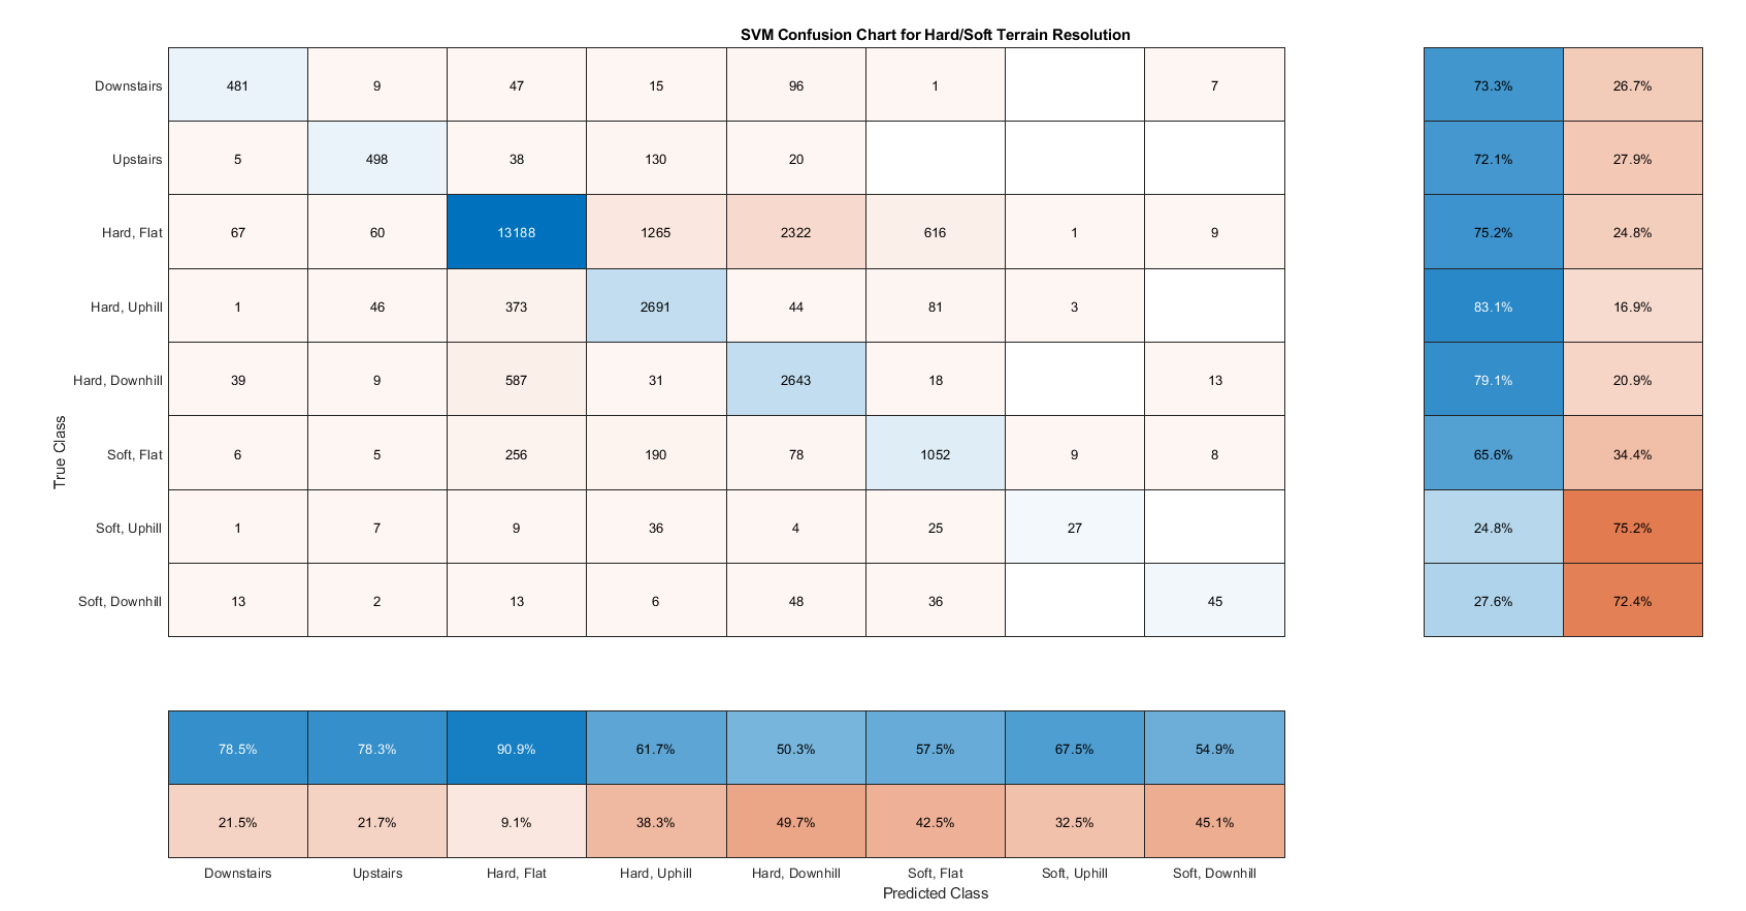
Figure A2. Support Vector Machine Confusion Chart for Level 2 label